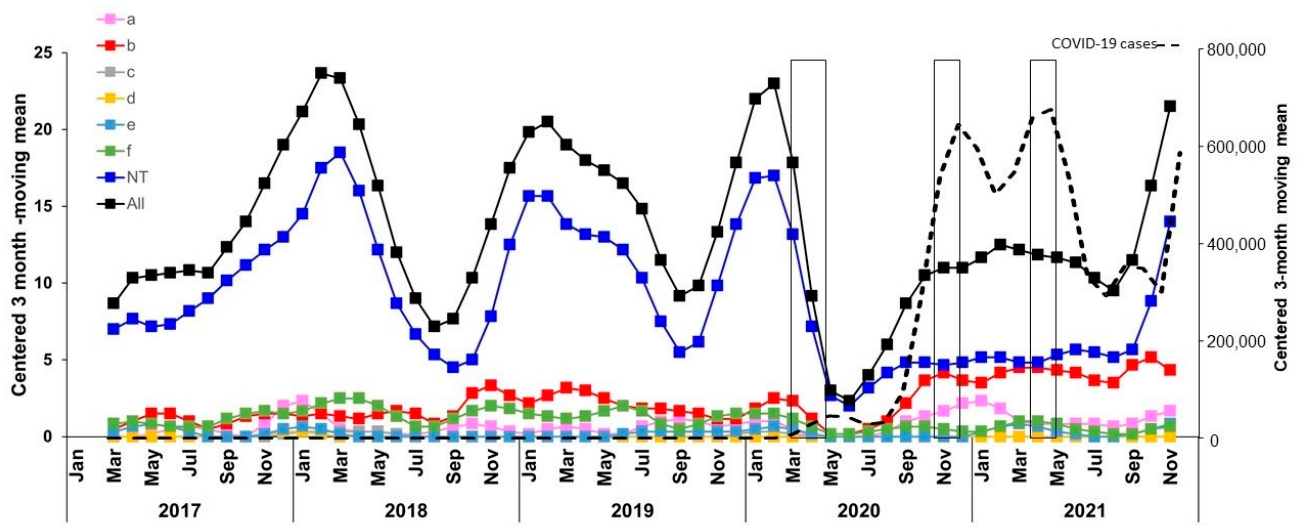
Figure 4. Evolution of IHiD cases by serotype. Data are expressed as the centered 3-month moving means of the number of cases per serotype. Serotypes are indicated in different colors. COVID-19 cases were also expressed using 3-month moving means (right axis). The three lockdown periods